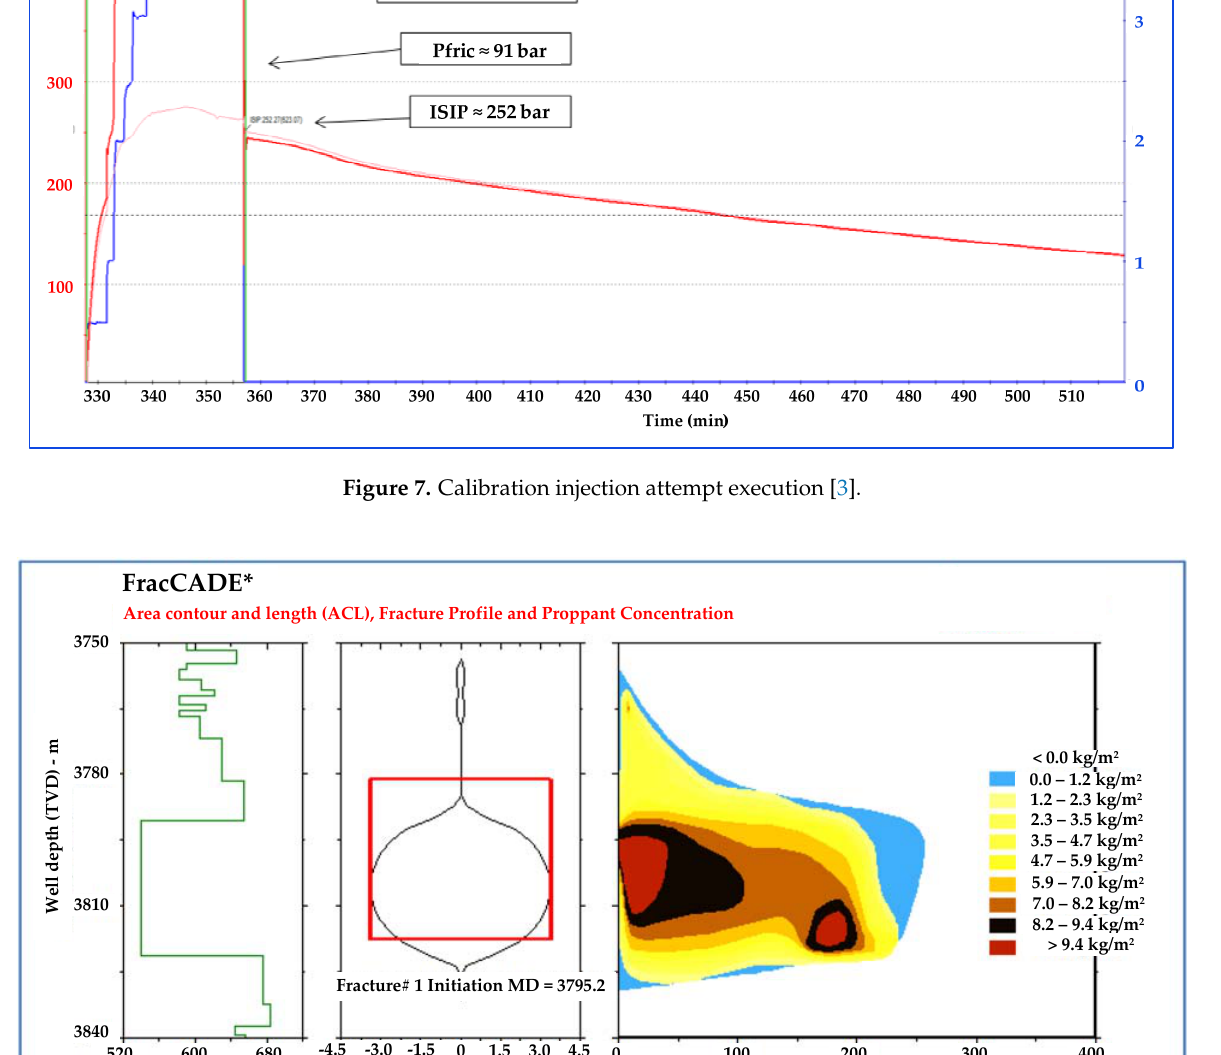
Figure 8. Fracture geometry profile as executed [3].